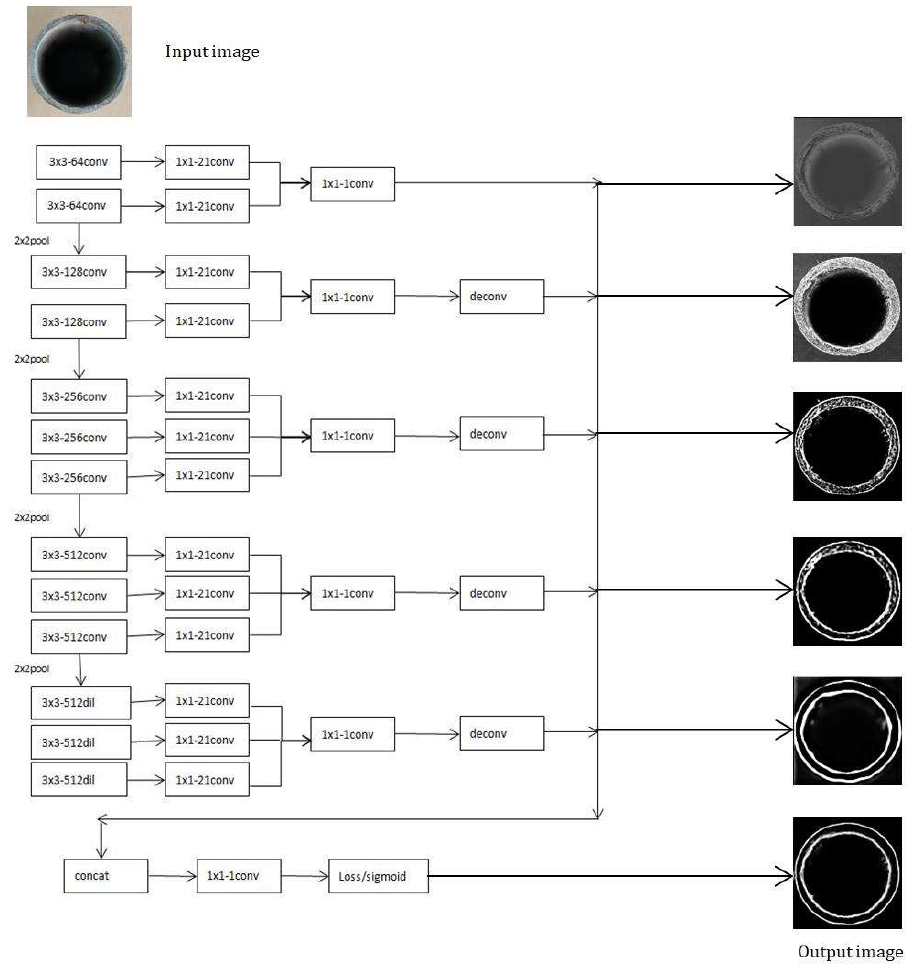
Figure 3. Network model in this paper.